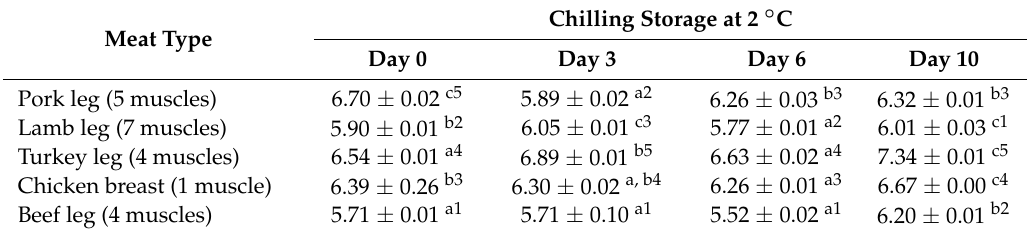
Table 1. pH values of the fresh different meat types during chilled storage at 2 ◦